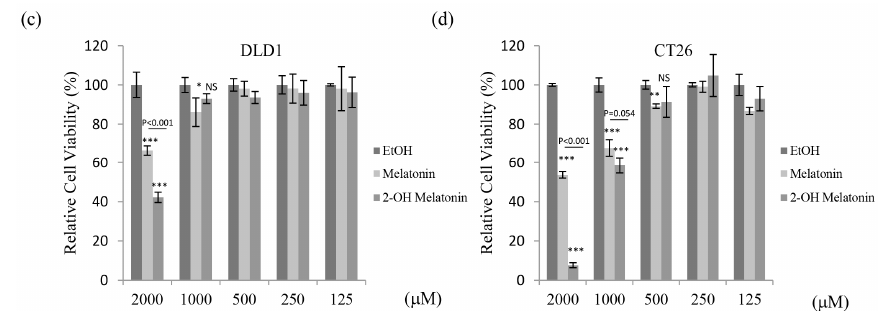
Figure 1. Cytotoxic effects of 2-hydroxymelatonin on human colorectal cancer cells. ( a – d ) Percentage viability of Caco2 ( a ), HCT116 ( b ), DLD1 ( c ), and CT26 ( d ) cells treated with melatonin or 2-hydroxymelatonin. Cells were treated with 125–2000 μ M melatonin or 2-hydroxymelatonin dissolved in ethanol for 48 h, and cell viability was measured by the MTT assay. Data represent means ± standard error of the mean, n = 3. * p < 0.05; ** p < 0.01; *** p < 0.001; NS, no significant difference compared with